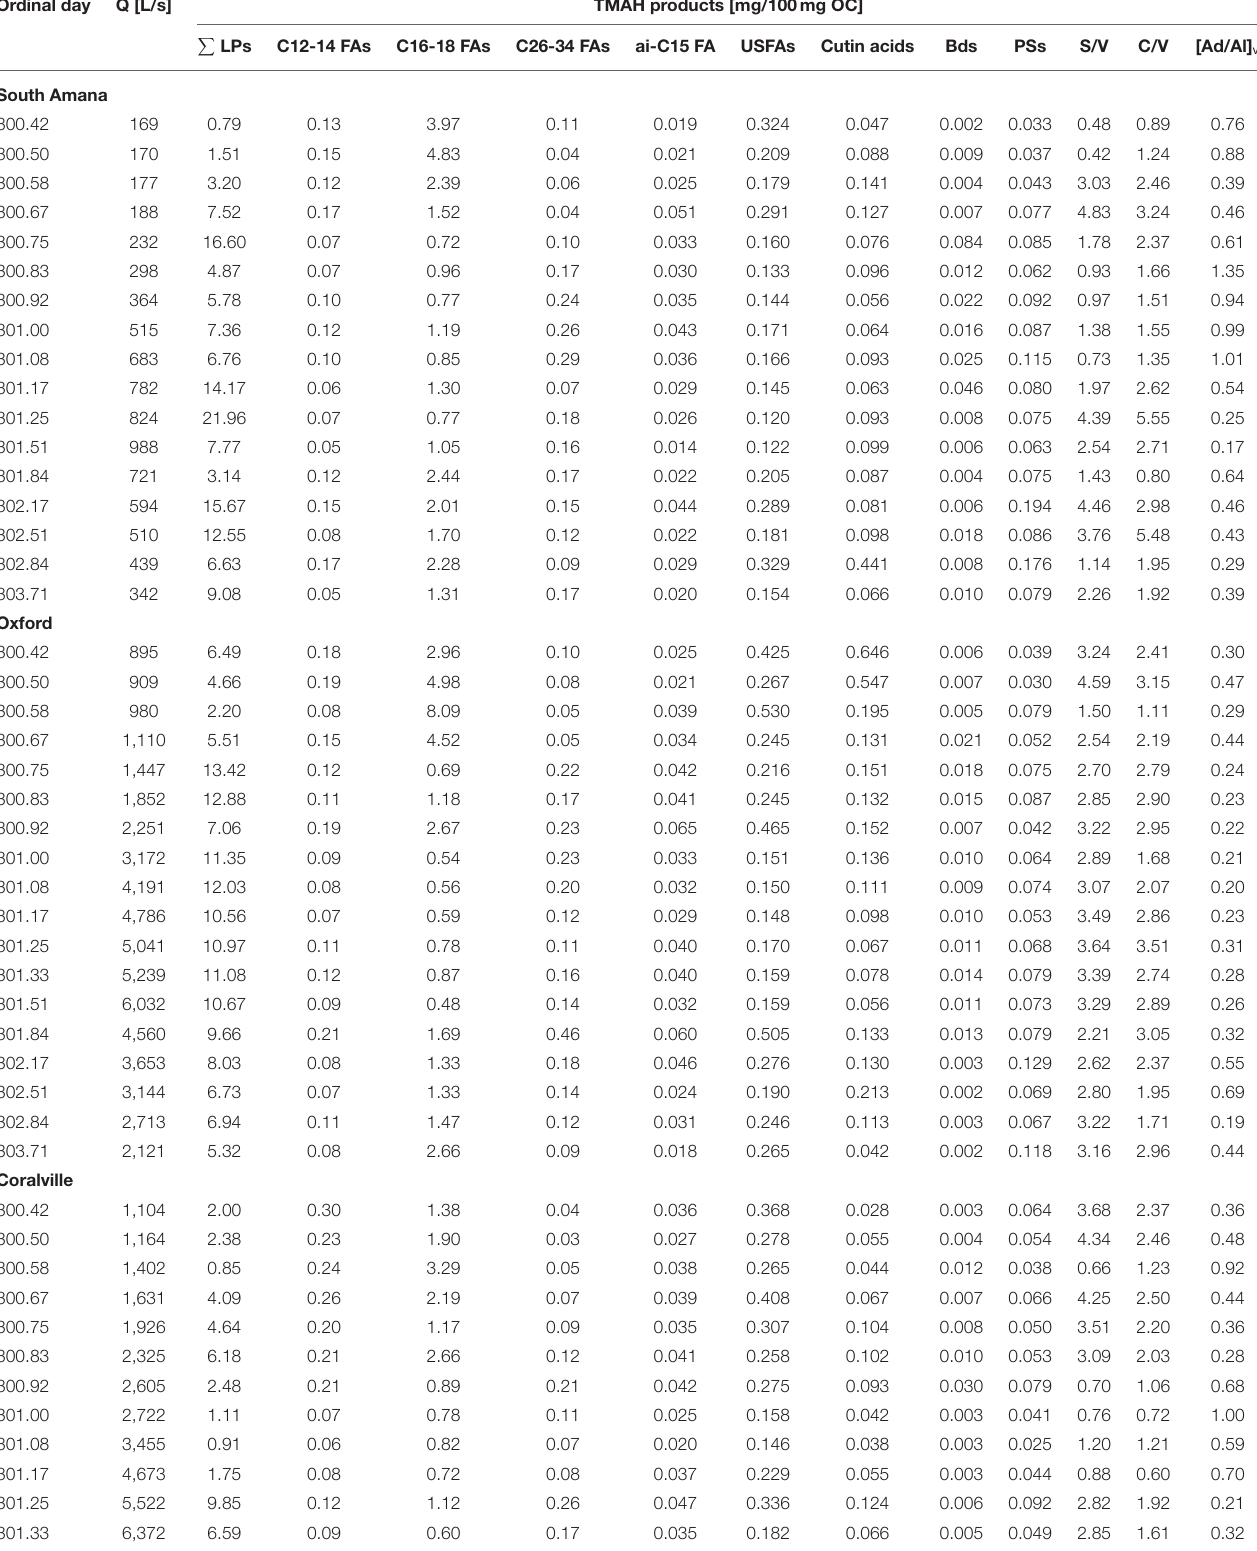
TABLE 4 | OC-normalized concentrations of TMAH products. Ordinal